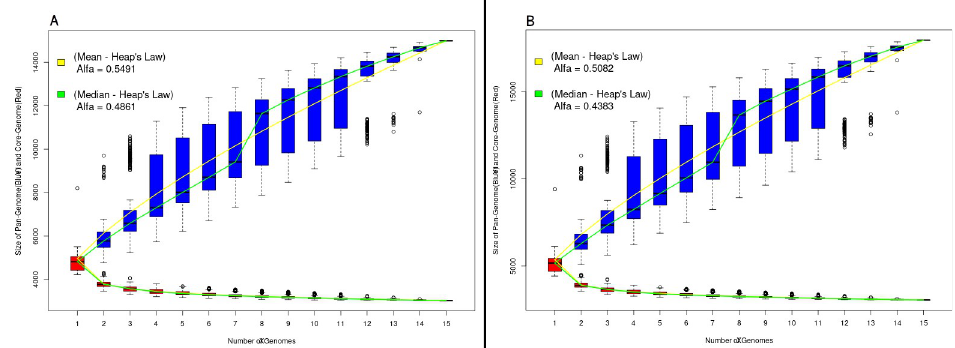
Fig 5. Result of pangenomic analysis using different annotation software. (A) pangenomic analysis using Prokka software and (B) analysis using the RAST platform.